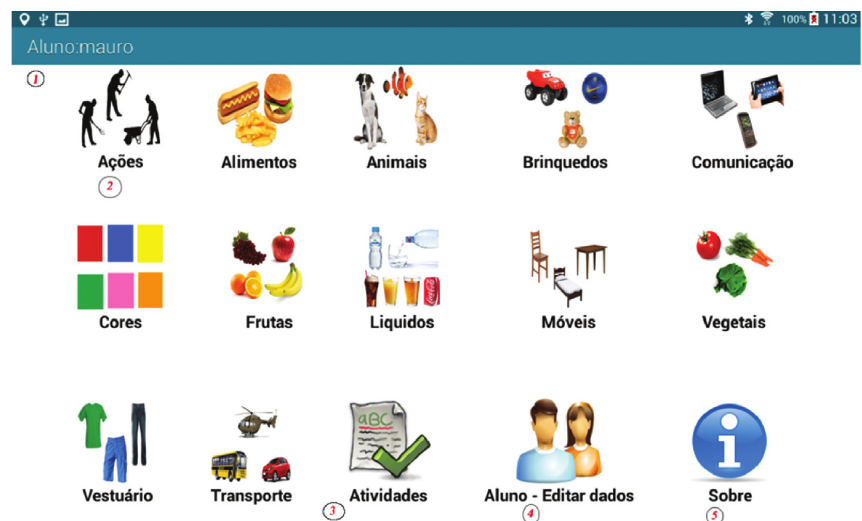
Figure 7: Library of symbols and categories.